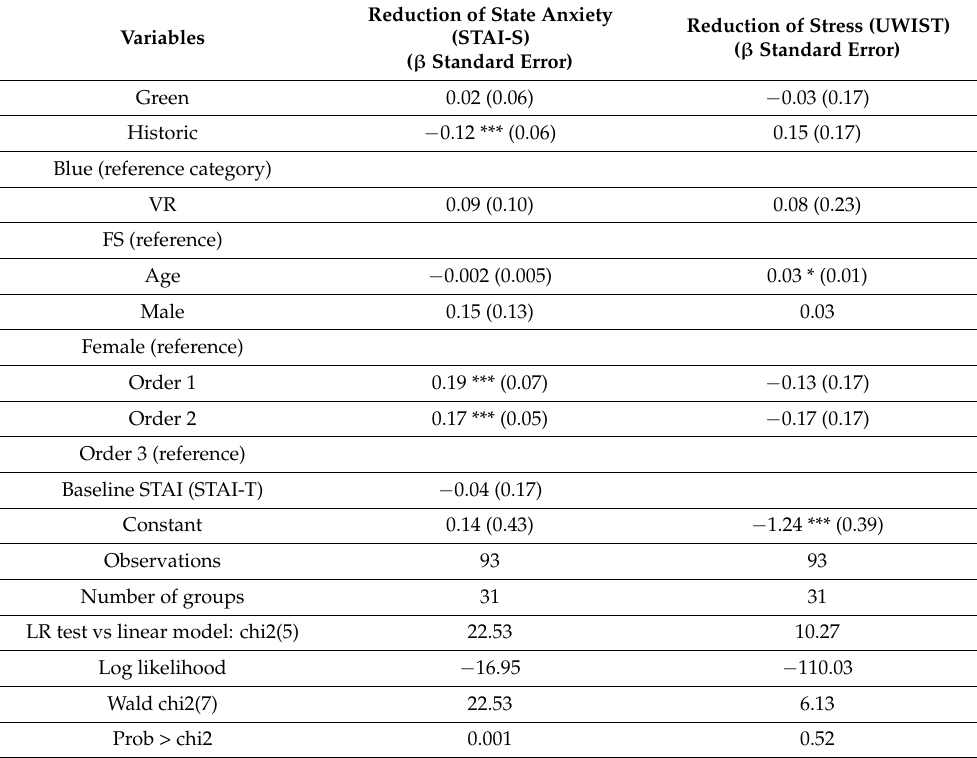
Table 3. Linear mixed-effects model for psychological outcomes (STAI and